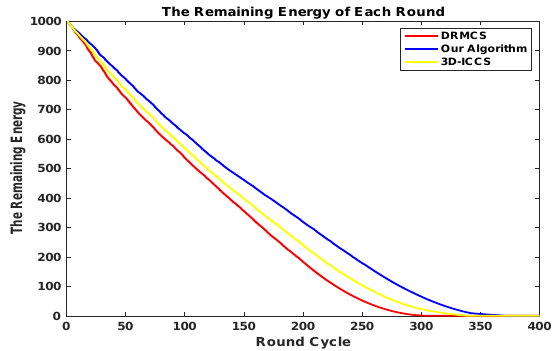
Figure 7. The comparison results in terms of total energy consumption.